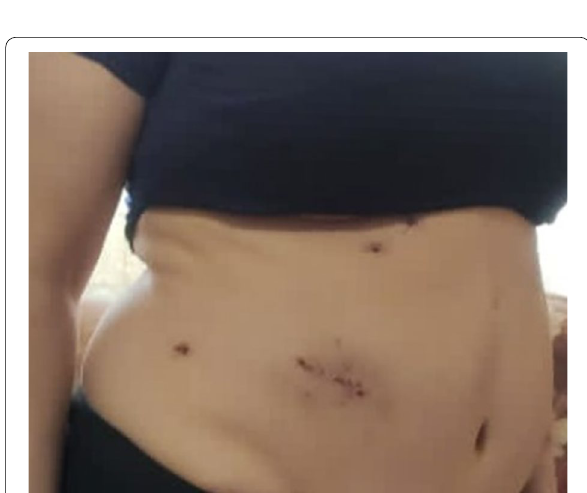
Fig. 3 visual representation of trocar sites. Mass was extracted from extended camera trocar site